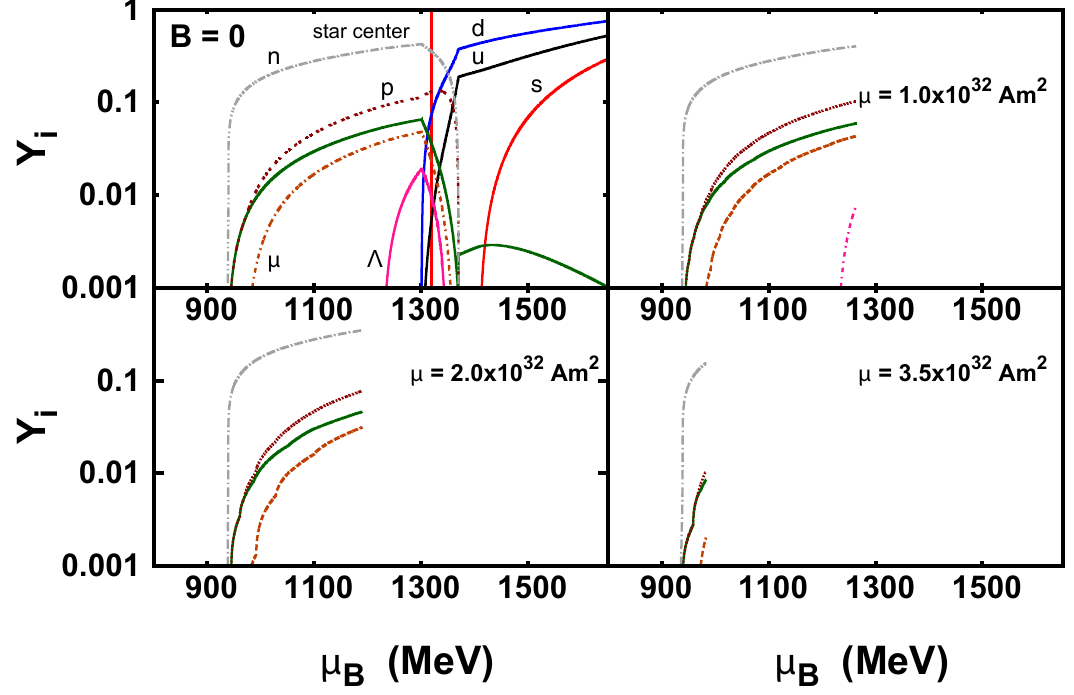
Figure 1. Particle population as a function of the baryon chemical potential calculated using the CMF model shown for different dipole magnetic moments µ . All figures represent equilibrium sequences obtained from the numerical solution of he Einstein-Maxwell equations at fixed baryon mass. For the non-magnetized case, the vertical red curve represents the chemical potential reached at the center of the star, namely, 1320